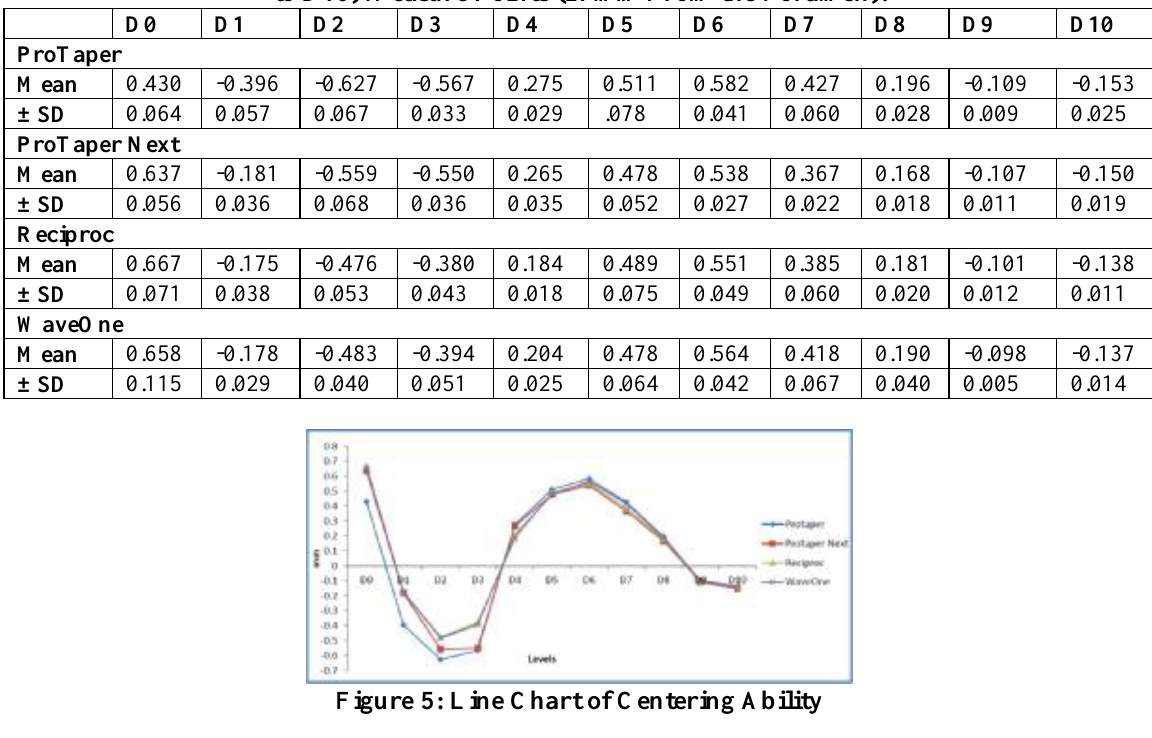
Table 1: Centering Ability Means and Standard Deviation at Different Levels of All Groups. (D0 to D10) Measure Points (in mm From the Foramen).